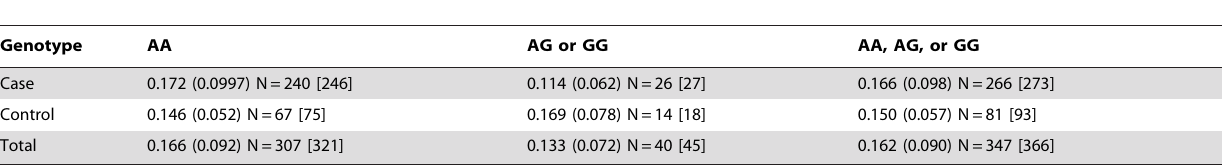
Table 5. Mean percentage of European ancestry segregated by genotype of